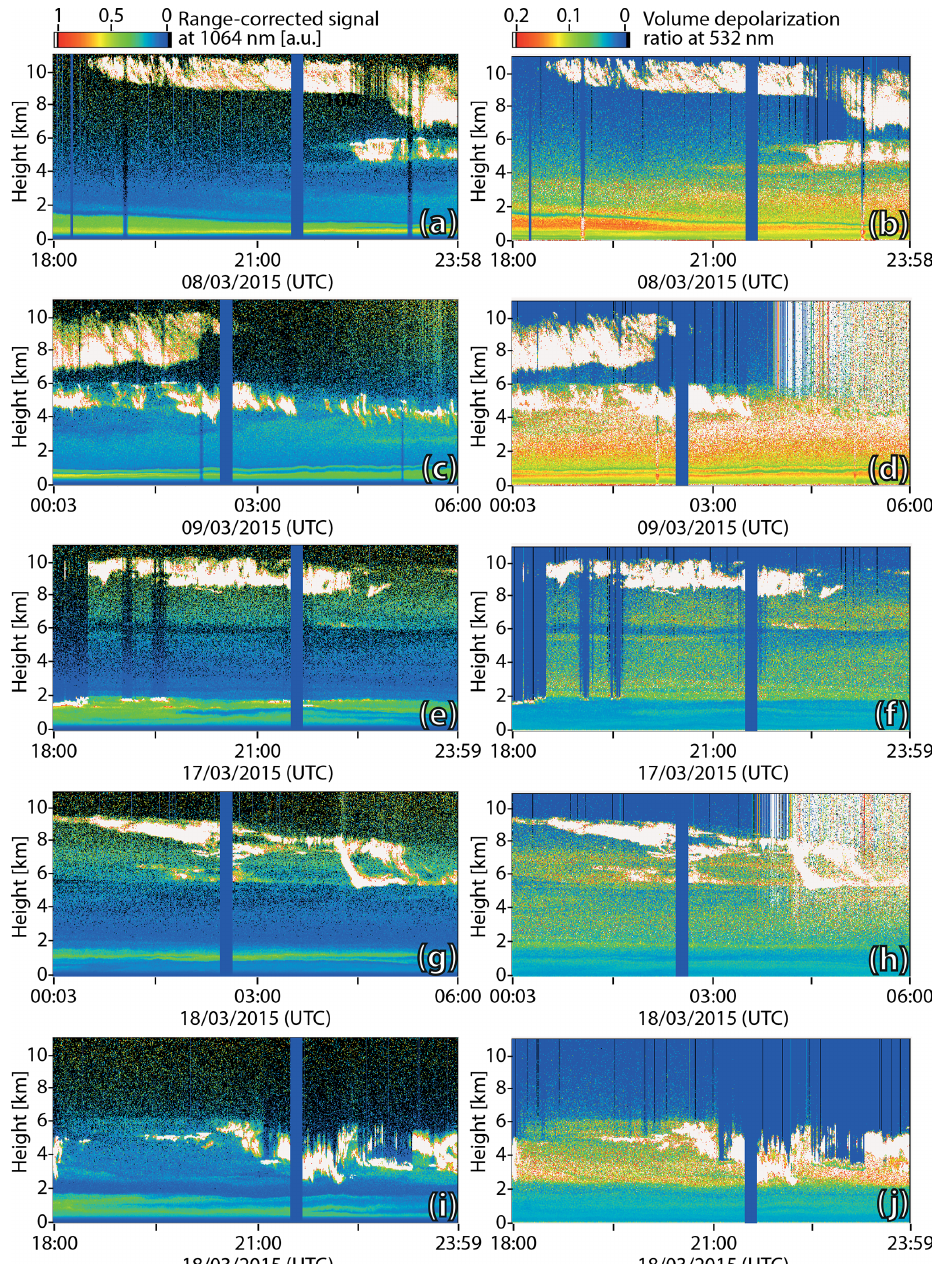
Figure 5. Cirrus and mixed-phase altocumulus layers (white areas) embedded in Saharan dust observed with polarization lidar during the BACCHUS Cyprus-2015 campaign. The range-corrected 1064nm signal (a, c, e, g, i) and the 532nm volume depolarization ratio (b, d, f, h, j) are shown. The depolarization ratio is especially sensitive to irregularly shaped particles such as mineral dust particles (values from 0.08 to 0.2, green to red) and ice crystals ( > 0 . 2, white). A remarkable coincidence of cloud layers with dust layers is visible which indicates a close link between dust occurrence and ice formation. The thin vertical columns (dark because of low signal strength) are caused by strongly light-attenuating liquid water clouds and near-surface fog. The well-defined broad vertical columns (around 02:30 and 21:40UTC) indicate automatically performed polarization lidar calibration